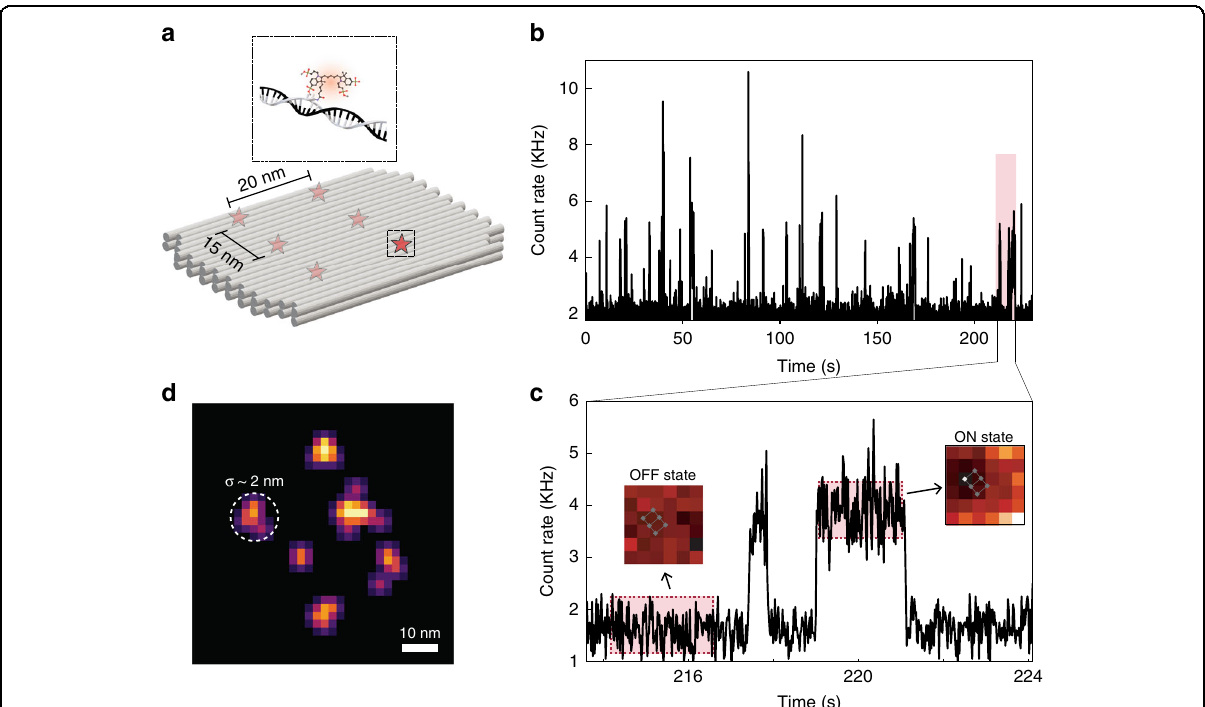
Fig. 3 RASTMIN nanoscopy. a Schematic of the DNA origami used to place six fl uorophores in a rectangular arrangement. b Fluorescence intensity time trace of representative 225 s of a RASTMIN measurement (frame time 20 ms) where single-molecule blinking events are detected. c Zoom-in of 10 s of the trace (highlighted region in b , 214 – 224 s) where two single-molecule emission events are observed. The inset images are the single- molecule 6 × 6 RASTMIN average frame corresponding to the periods highlighted in the time trace. During the single-molecule emission, a displaced image of a paraboloid is observed. d Reconstructed image of the DNA origami from the localizations obtained by RASTMIN, where a localization precision of σ ¼ 2 nm can be observed ( N (cid:3)